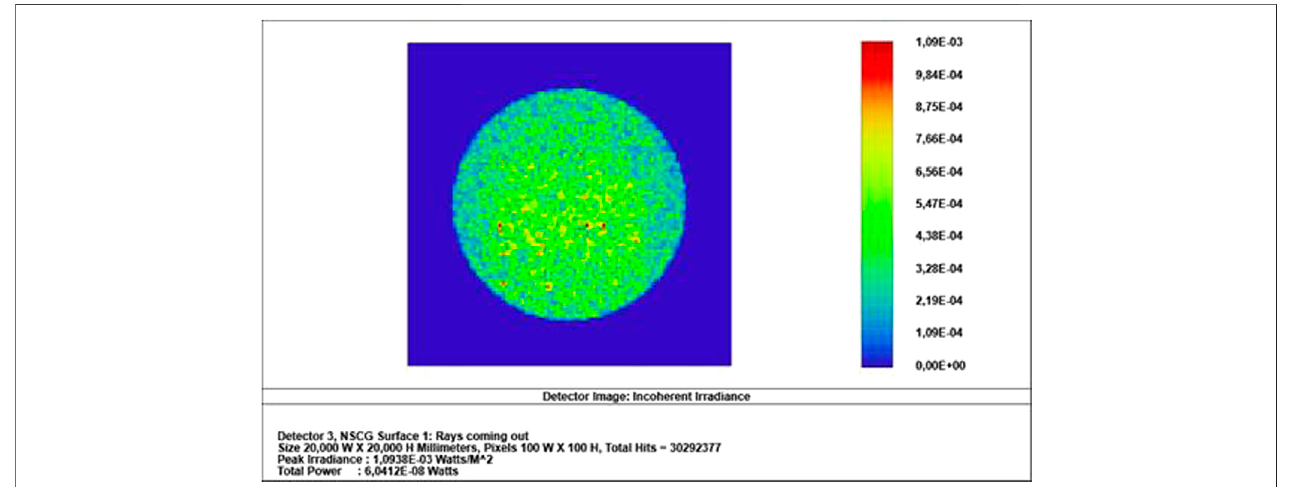
FIGURE 10 | Simulation results of incoherent irradiance distribution of the cavity C3 in a simpli fi ed ESR layout for TSI measurement.